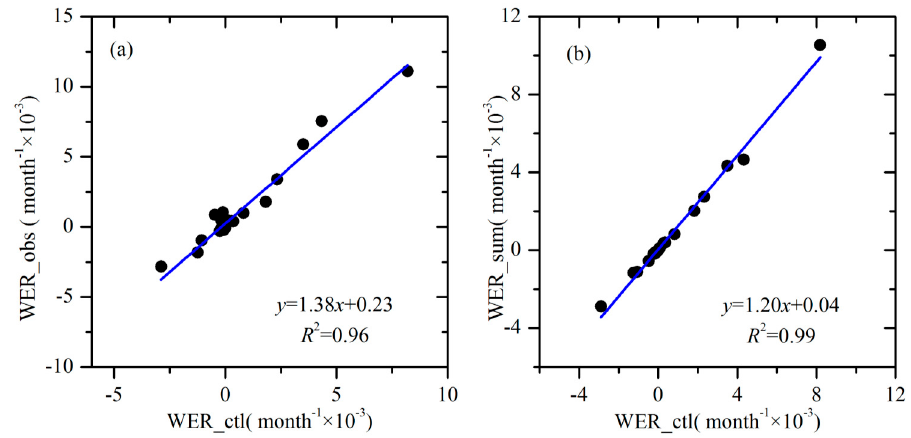
Figure 6. Comparisons between ( a ) trends in WER based on the control test and observations, and ( b ) trends in WER based on the control test and the cumulative contributions of the three sensitivity tests.